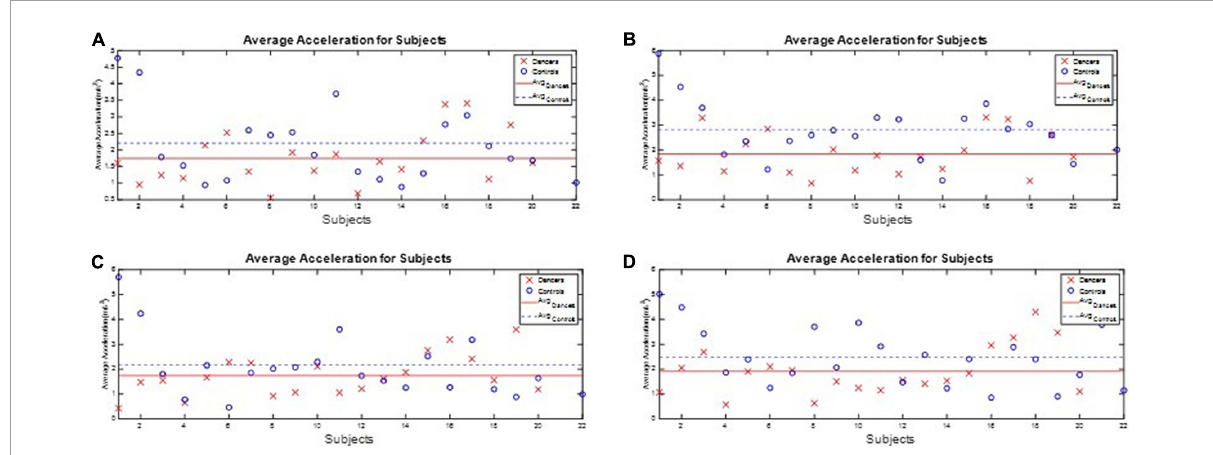
FIGURE11 The performance index J 4 during the one-leg stance tests. The dancers’ linear acceleration index J 4 were about 79.39, 65.20, 80.18, and 77.61%, respectively, of the healthy controls during the four actions. (A) Standing on the dominant foot with eyes open. (B) Standing on the dominant foot with eyes closed. (C) Standing on the non-dominant foot with eyes open. (D) Standing on the non-dominant foot with eyes